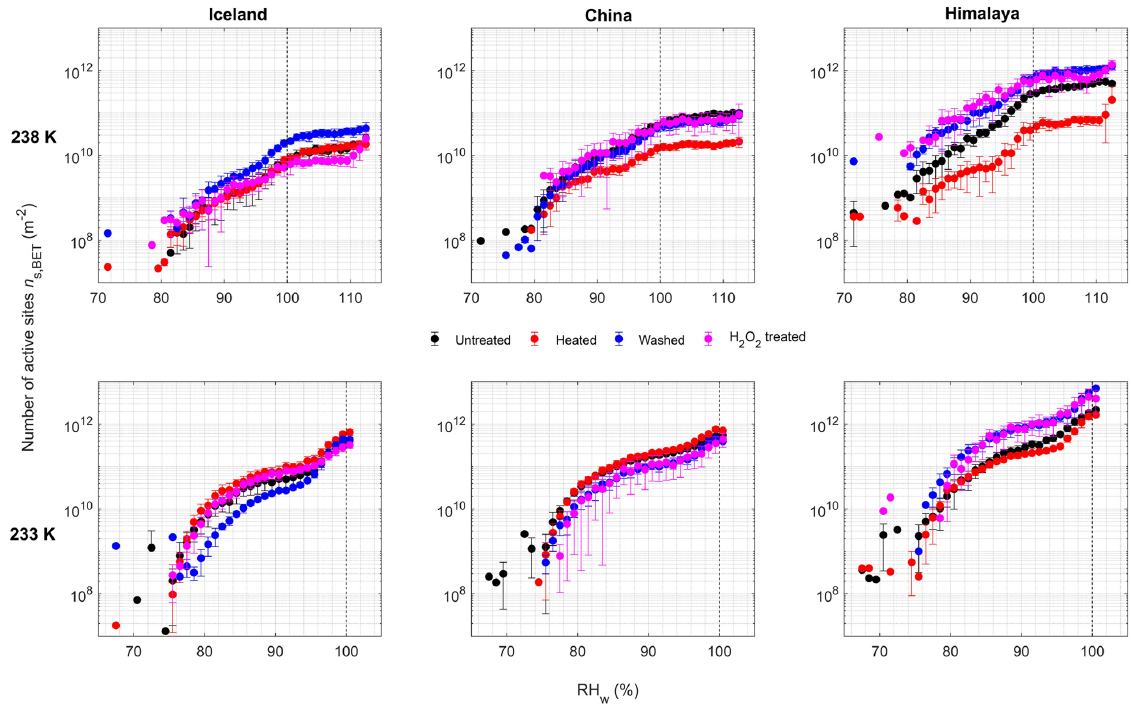
Figure 4. Average n s , BET values as a function of RH w for the untreated and treated dusts for 200nm particles. Results for temperatures of 238 and 233K are shown. The values are averaged into 1% RH w bins, and the error bars represent 1 standard deviation. The vertical dashed line is the water saturation (RH w = 100%)